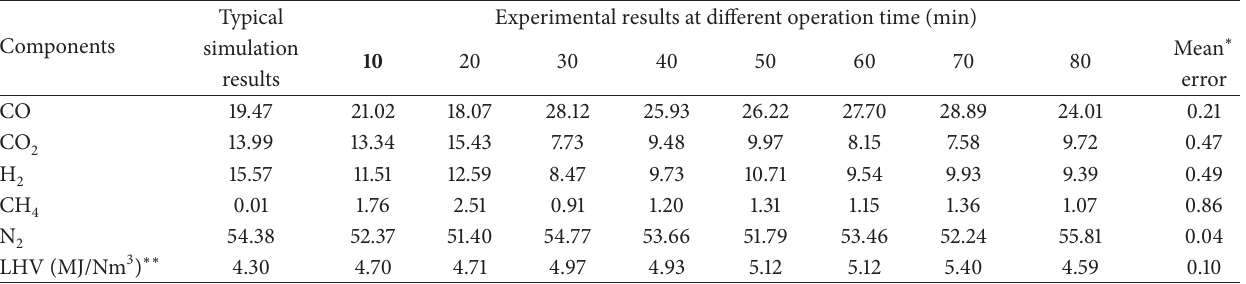
Table 4: Comparison of typical simulation results with experimental values.